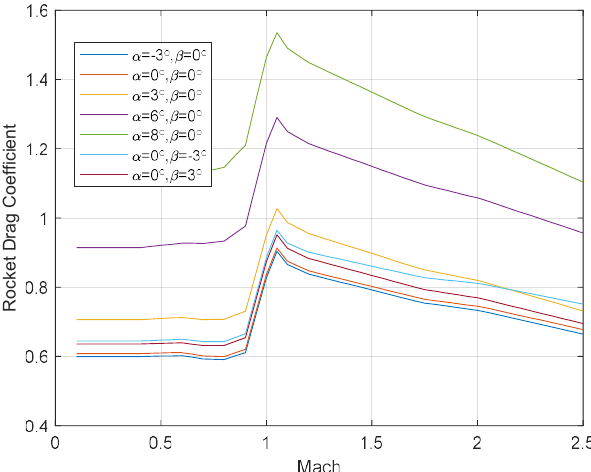
Figure 6. Drag Coefficient with Correction Fuze.